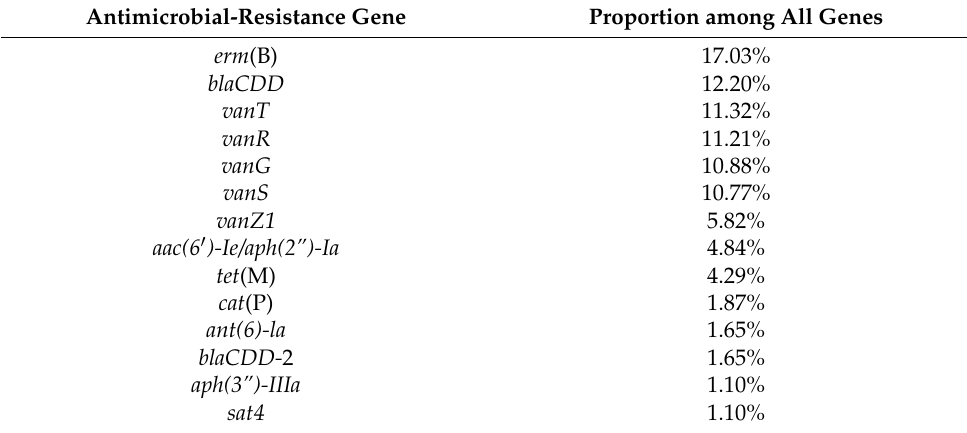
Table 2. Proportion of antimicrobial-resistance genes harbored in mobile genetic elements in the 1101 genomes of C. difficile available in the GenBank database 1